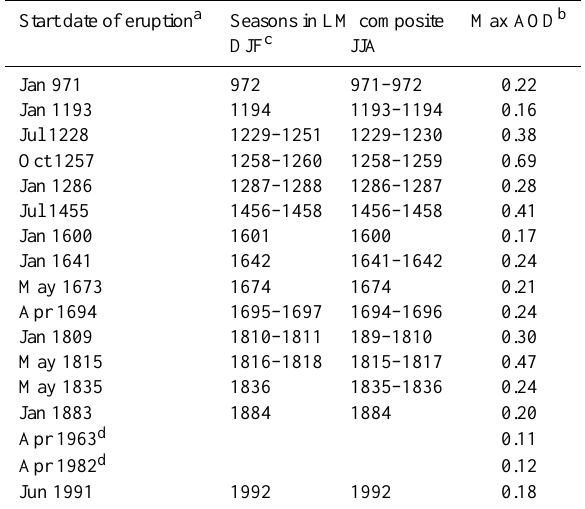
Table 1. Time of eruptions and global aerosol optical depth (AOD) from Crowley and Unterman (2013). List of eruptions used in study. List of LM and L20